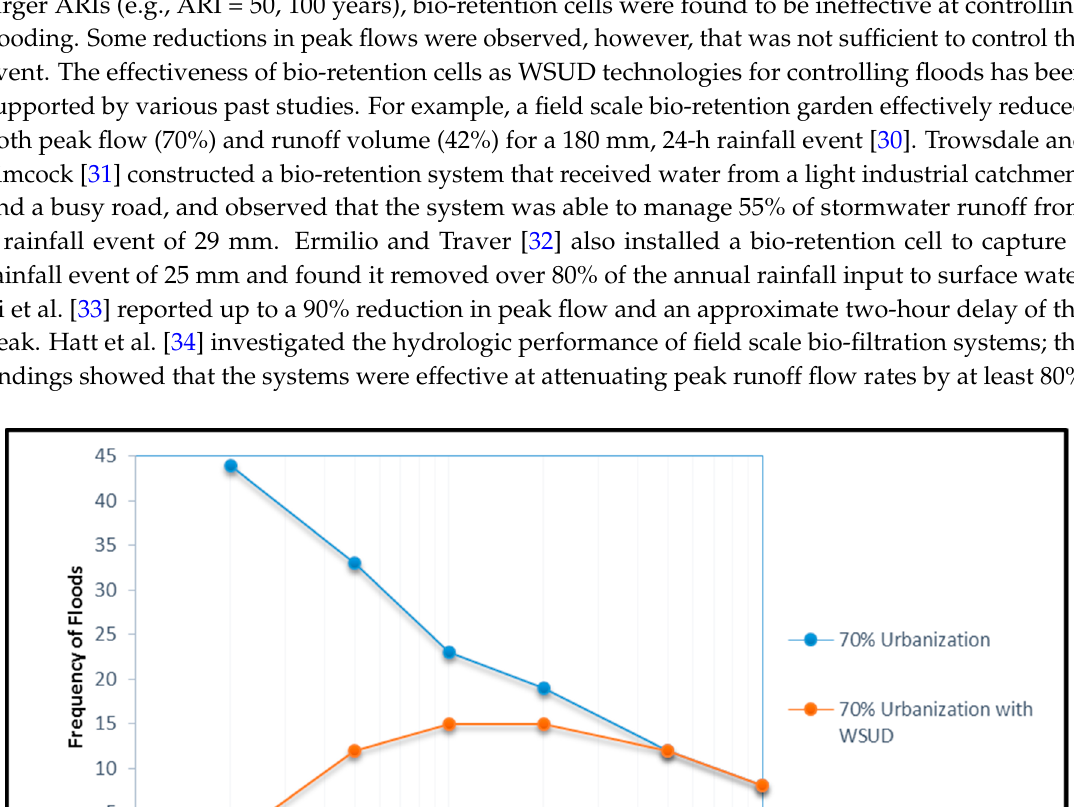
Figure 12. Flood frequencies at the catchment outfall with and without WSUD technology.